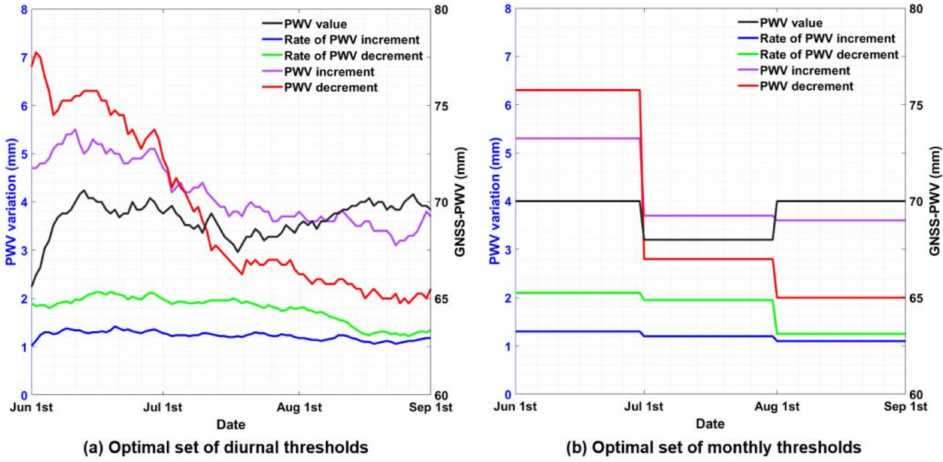
Figure 6. Optimal set of diurnal ( a ) and monthly ( b ) thresholds of five predictors determined for the summer season using sample data in the month over the period 2010–2017 from the co-located HKSC-KP stations.